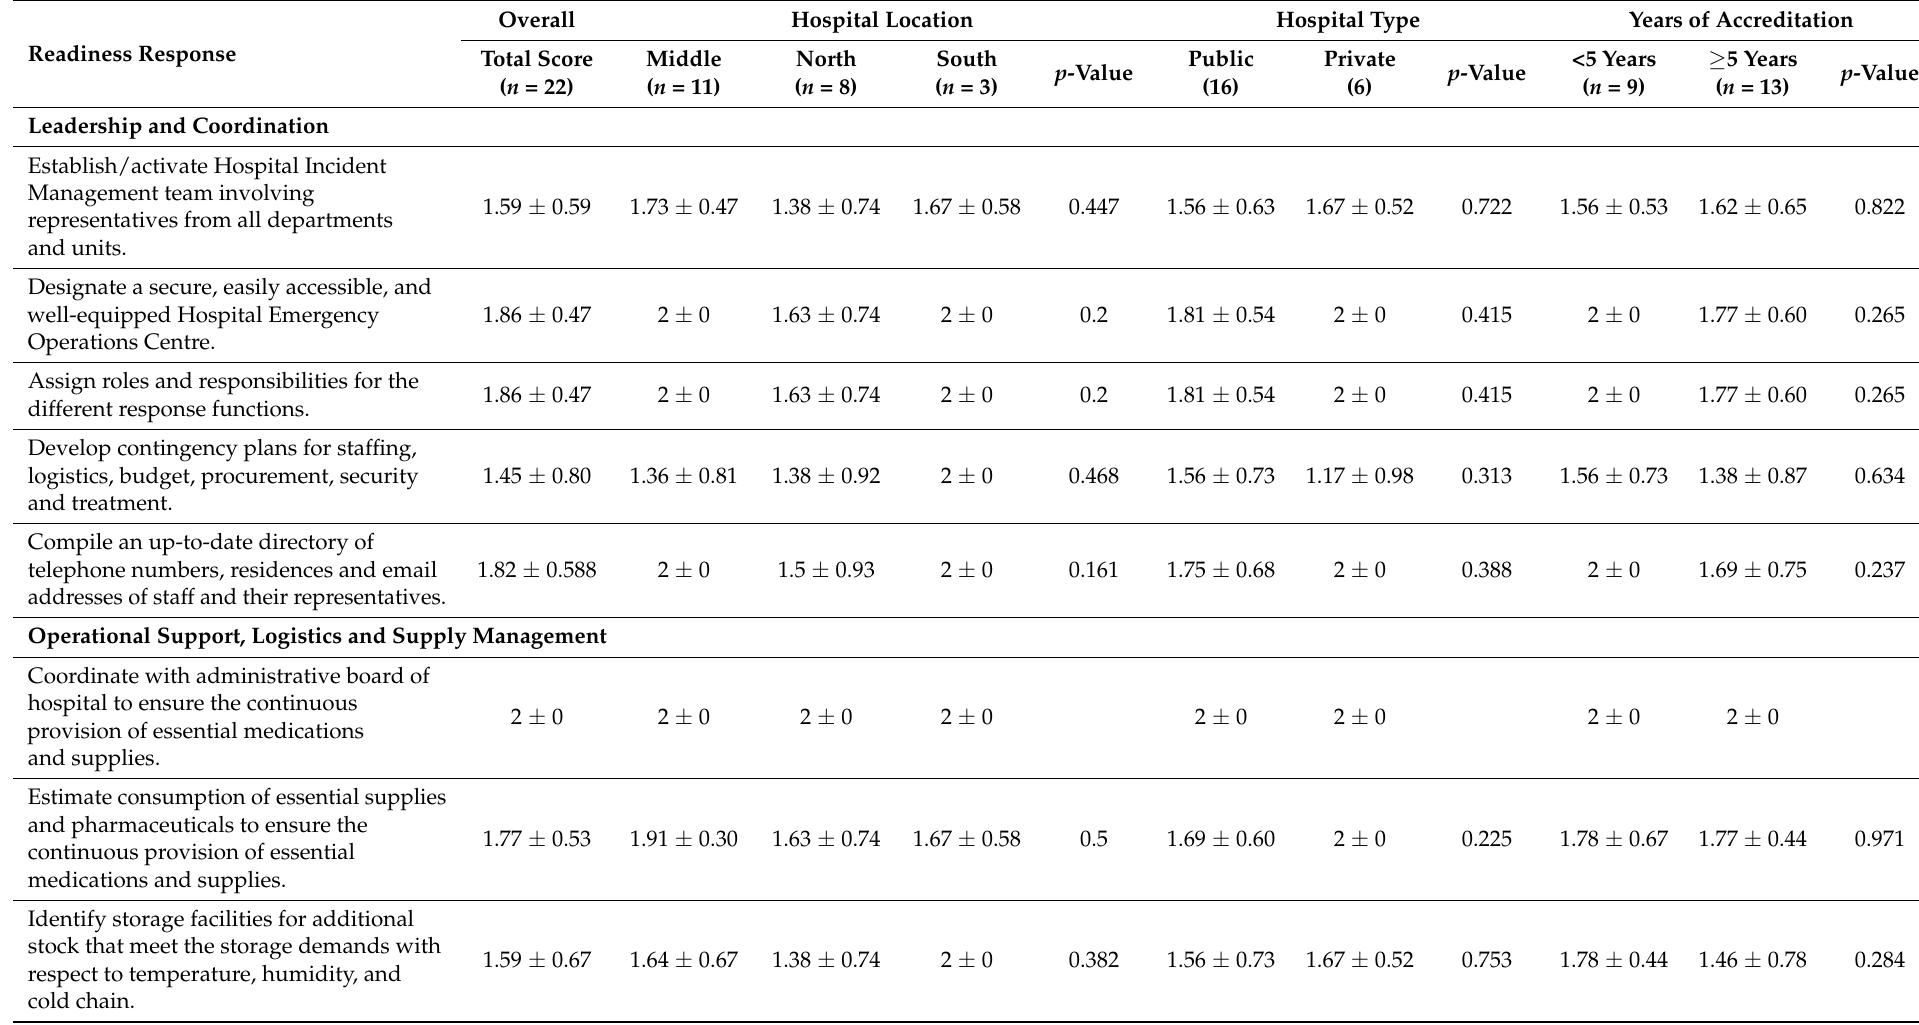
Table 4. Detailed average compliance score of participating hospitals according to response function stratified according to hospital location, type and years